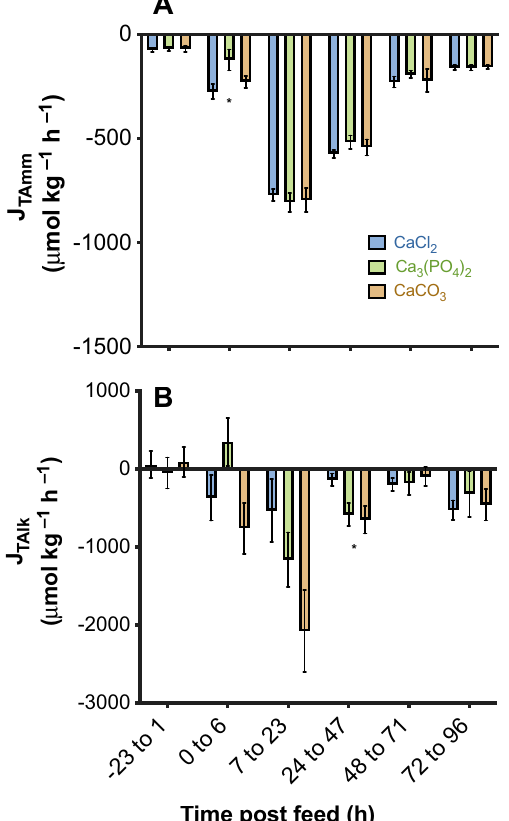
Figure 3. Average flux of titratable alkalinity (J T-Alk ) ( A ) and ammonia (J T-Amm ) ( B ) over time in juvenile rainbow trout ( Oncorhynchus mykiss ) fed a 2.5% ration of one of three experimental feeds supplemented with either Ca 3 (PO 4 ) 2 , CaCO 3 or CaCl 2 (JTalk: n = 9 for Ca 3 (PO 4 ) 2 and CaCO 3 treatments; n = 8 for the CaCl 2 treatment; JTamm: n = 10 for all treatments). Data are expressed as means ± SE. Asterisks (*) indicates significant difference between diet groups within flux periods following a one-way ANOVA and Tukey